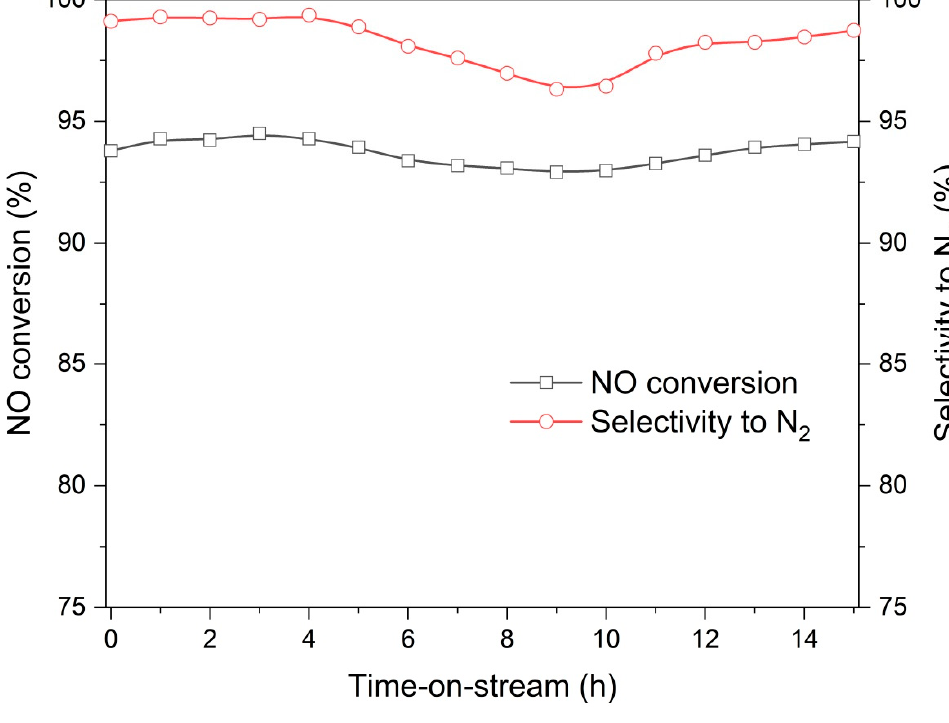
Figure 10. Results of stability NH 3 -SCR test for Cu-ITQ-6_30 at 275 ° C.